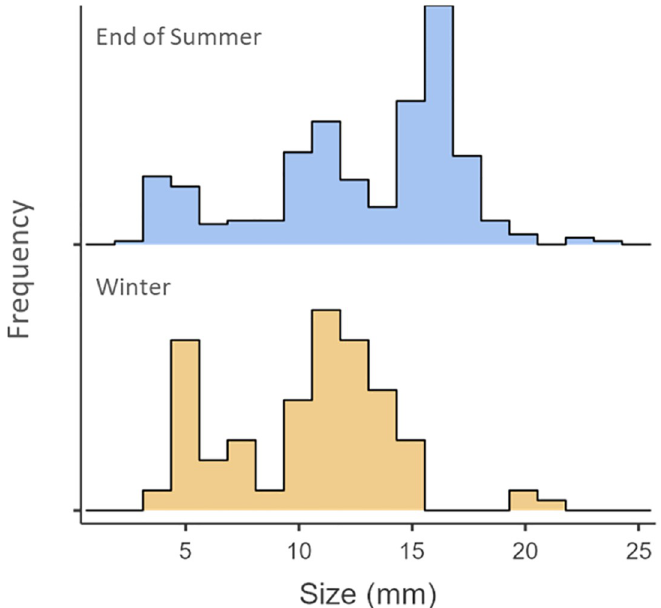
Fig 5. C . fluminea shell sizes. Histograms of live C. fluminea shell size recovered during the winter 2020–2021 sampling (bottom, n = 103) and end of summer 2021 sampling (top, n =